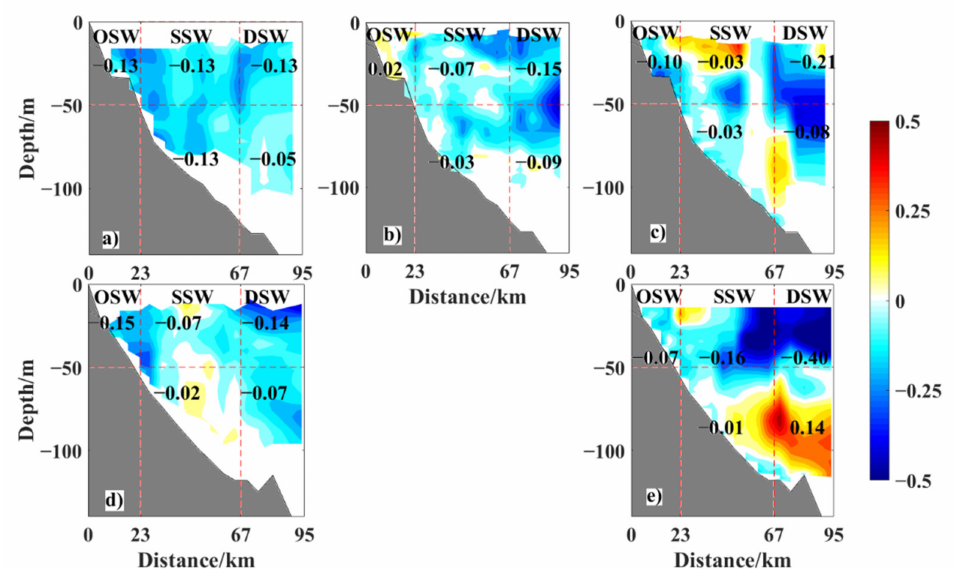
Figure 6. 2D ( x – z ) distributions of cross-shelf velocity components v c (m/s) in section H ( a ) and F ( d ) without the typhoon, section H ( b ) before the typhoon, and sections H ( c ) and F ( e ) after the typhoon. Red dotted lines represent the positions of the 50 m isobath, the 120 m isobath, and a depth of 50 m. Numbers represent the average velocities in the portions of